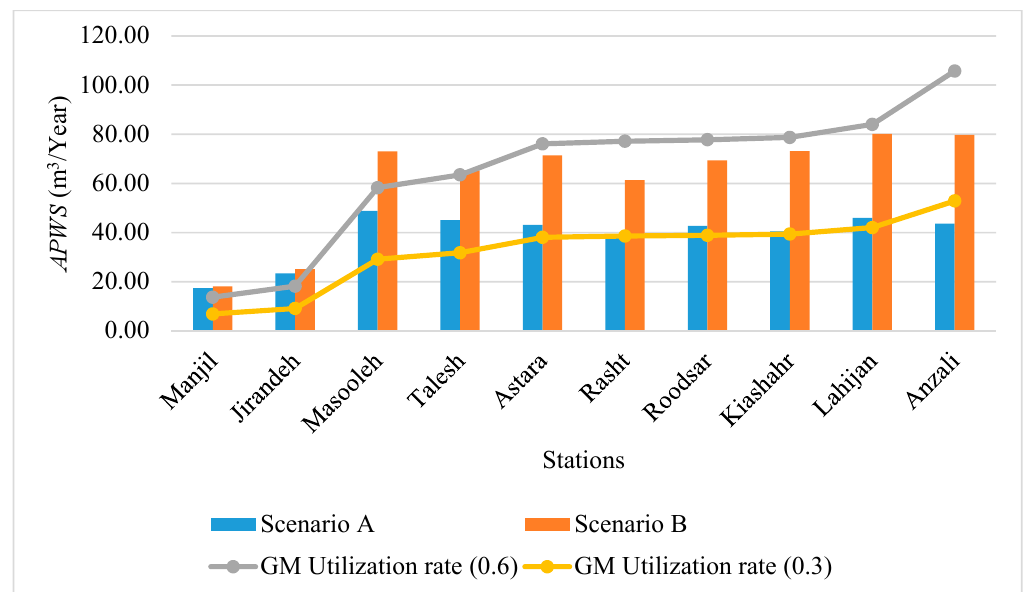
Figure 8. Comparison of APWS in scenarios A and B of tank size 3 m 3 and the generalized method.